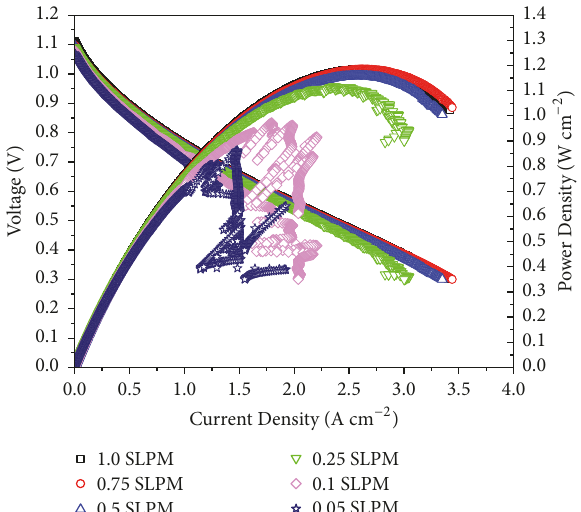
Figure 11: Voltage and power density curves versus current density at different air flow rates at 750 ∘ C.